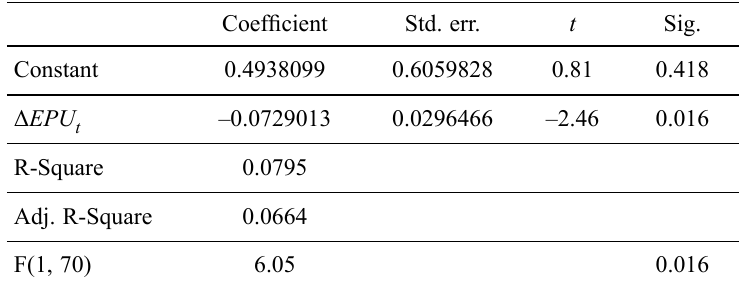
Table 4. Regression results obtained from Equation (1)